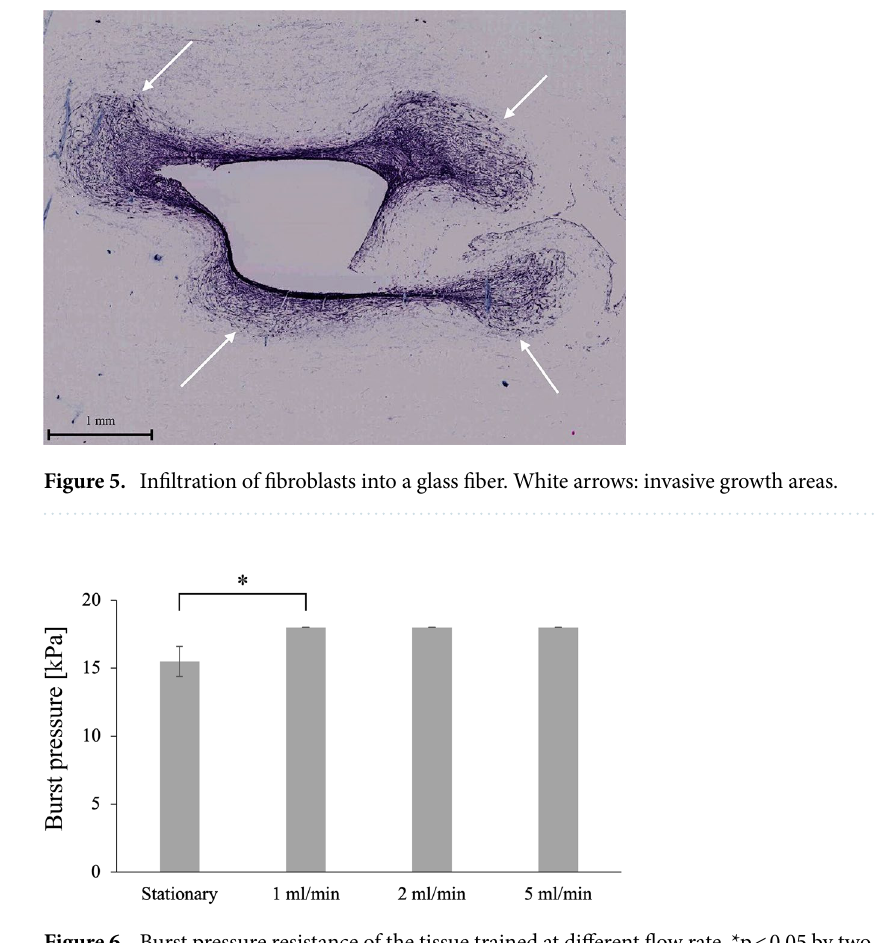
Figure 6. Burst pressure resistance of the tissue trained at different flow rate. *p < 0.05 by two-tailed t-test with an alpha level of 0.05. The error bar represents the standard deviation of the